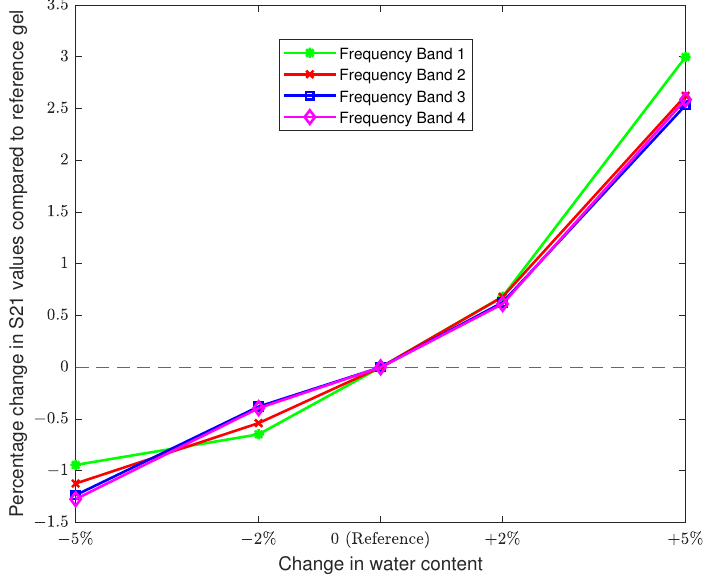
Figure 3. Plot of changes in electromagnetic transmission coefficient (S21) measurements of agar phantom gels with increasing water